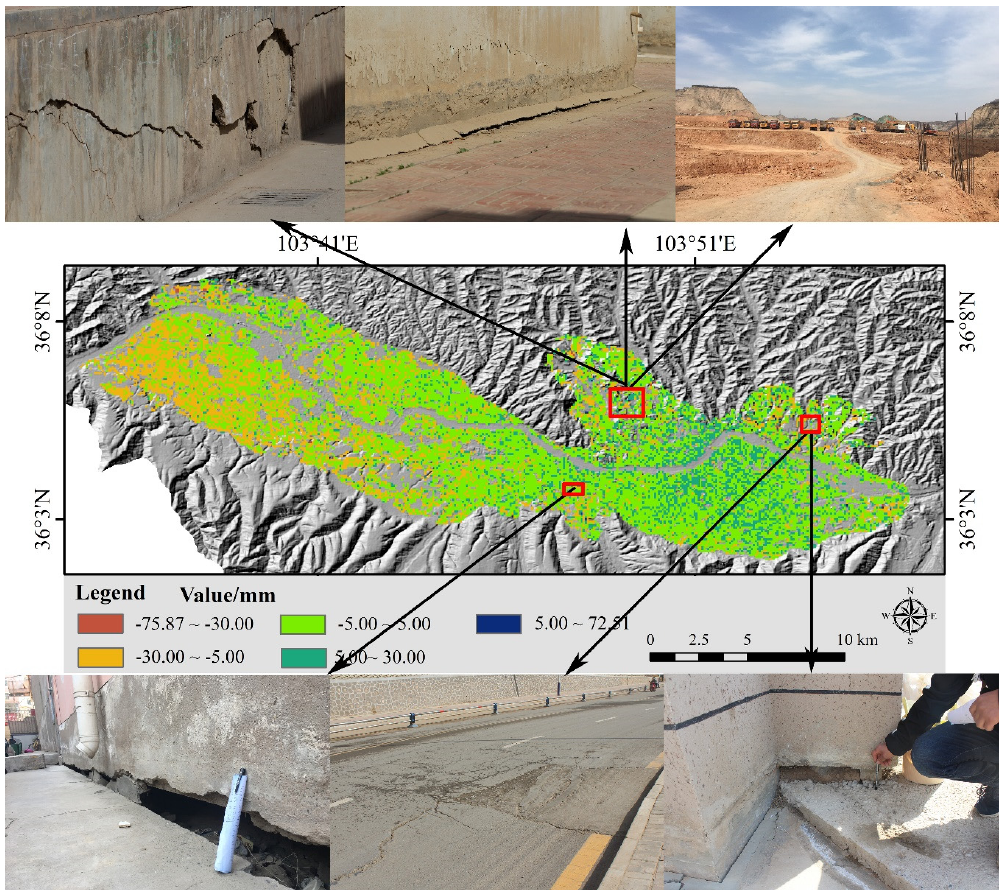
F igure 5. Distribution of the differences in the PS-InSAR and SBAS-InSAR results. Figure 5. Distribution of the di ff erences in the PS-InSAR and SBAS-InSAR